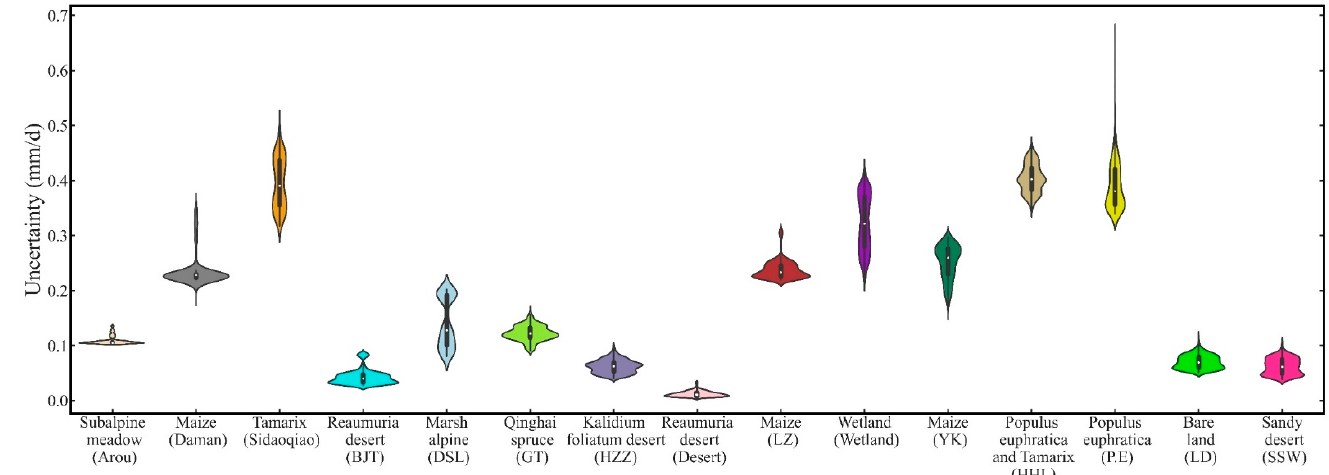
Figure 13. Violin plots (the length and width represent the range and frequency, respectively, and the black bar shows the third quartile, median, and first quartile from top to bottom) for the uncertainty of the ground truth ET at the pixel scale at fifteen typical surface type sites in the HRB during the period from 2010 to 2016.